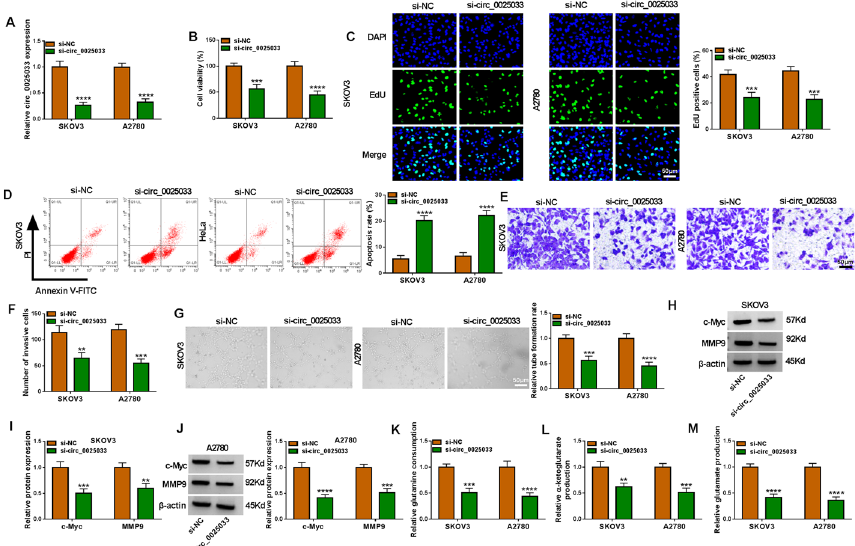
Fig. 2 circ_0025033 knockdown hampered the malignant behavior of ovarian cancer cells in glutamine metabolism. A – M SKOV3 and A2780 cells were transfected with si-NC or si-circ_0025033. A qRT-PCR analysis of circ_0025033. B and C CCK-8 and EdU analysis of cell viability and DNA synthesis. D Apoptosis rate analyzed by flow cytometry analysis. E and F Cell invasion measured by transwell assay. G Tube formation assay for evaluating angiogenesis activity. H – J Western blot analysis of c-Myc and MMP9 levels. K – M Glutamine consumption, α-ketoglutarate production, and glutamate production measured via glutamine, α-ketoglutarate, and glutamate assay kits, respectively. ** P < 0.01, *** P < 0.001, **** P <